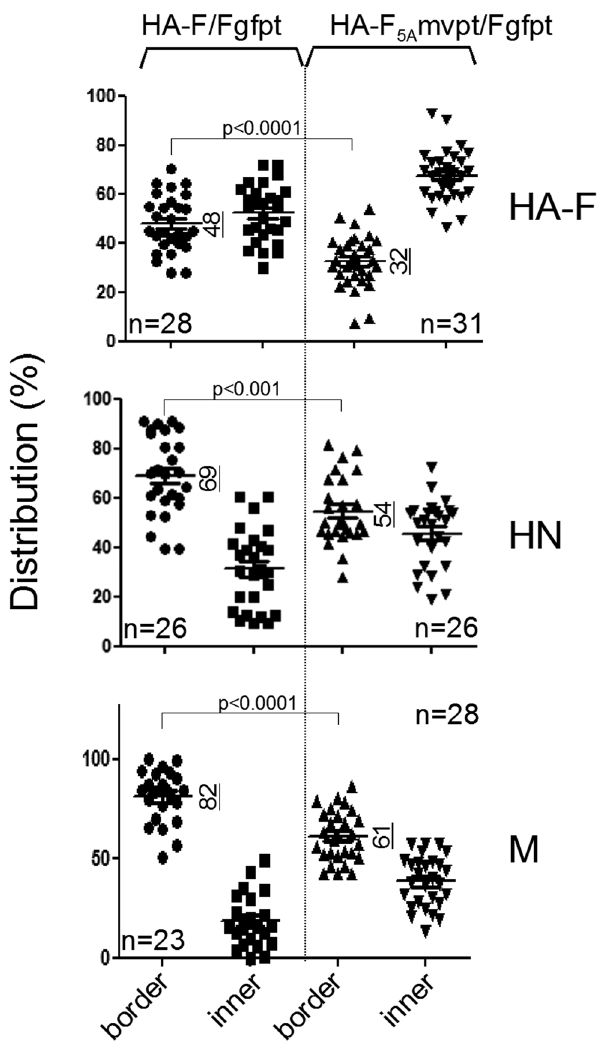
Figure 7. Statistical analysis of F, HN and M distribution in infected cells. Total immunofluorescence confocal images of rSeV-HA- F/Fgfpt (HA-F/Fgfpt) and rSeV-HA-F 5A mvpt/Fgfpt (HA-F 5A /Fgfpt) infect- ed a -gfpt siRNA expressing MDCK cells as those presented in figures 6 and 8 were analysed through a Metamorph program presented in supplemental figure S3, designed to quantify the fractions of the proteins HA-F, HN and M at the cell border or in the inner compartment. n=x: refers to the number of cells involved. Graphical representation of the data was executed by Graph Pad Prism 6 software which also provided the statistical calculation of the unpaired two-tailed Student t test. Underlined vertical numbers=numerical averages.